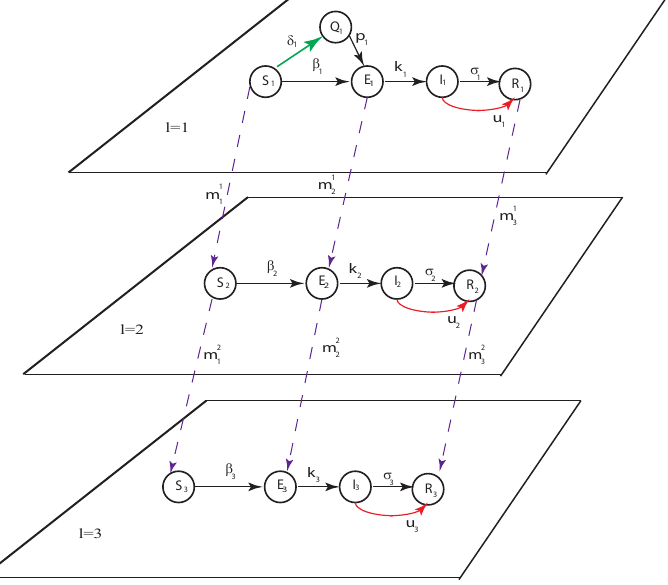
Figure 2. The scheme of transition between groups S , Q , E , I , R , and hierarchical levels. We model the epidemic process as a system of nonlinear differential equations, where N i ( t ) is size of the population on the level i at the time moment t . n S number of susceptible individuals, n Q the number of exposed individuals, n I number of recovered individuals. The next conditions should be satisfied: n S